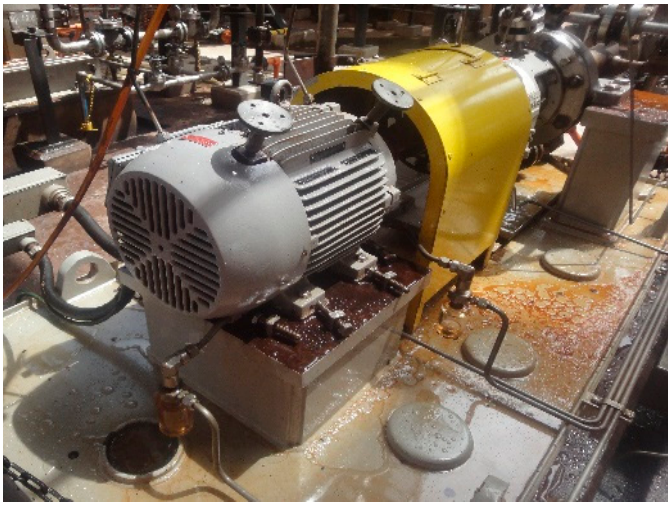
Figure 3. Industrial electric motor driving a wastewater pump.